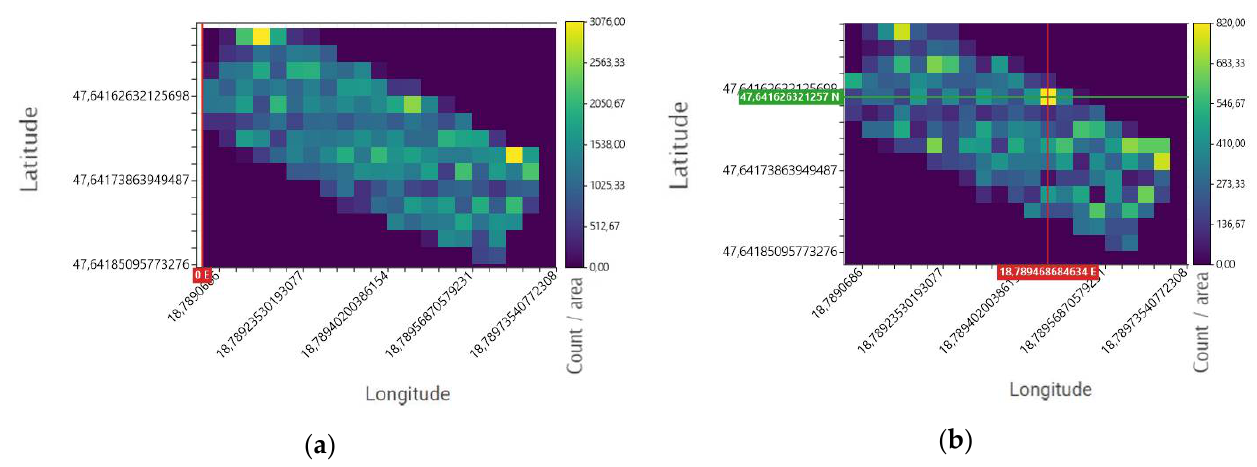
Figure 9. Shows the dose distribution map generated by the processing program without an energy window (( a ) panel) and using an energy window (( b )